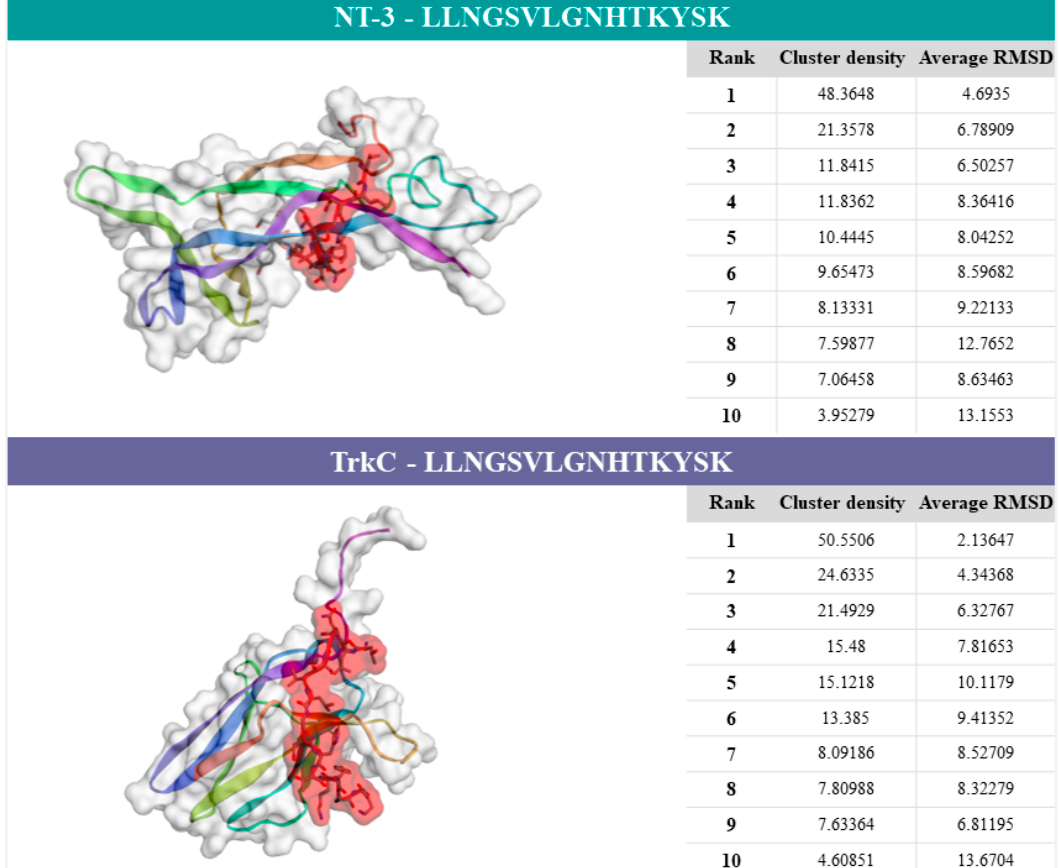
Figure 3. Fluorescence microscopy images of blood T lymphocytes. Legend: fluorescence micros- copy images of blood T lymphocytes. T cells were stained with anti-NEText + anti-Alexa Fluor 488 (green color) and anti-NT-3 + anti-Alexa Fluor 594 (red color) antibodies; or anti-NEText + anti- Alexa Fluor 488 (green color) and anti-TrkC + anti-Alexa Fluor 594 (red color) and expanded from peripheral blood mononuclear cells with an HCX PL APO CS 63.0 × 1.40 OIL UV objective. The white bar represents 10 µm. ( a ) NEText–NT-3 staining of T lymphocytes of patients with schizophrenia and controls. ( b – d ) Intensity profile graphs (distance in pixels vs. intensity in grey-scale values) of T cells of patients with schizophrenia (red) and controls (green): ( c ) distribution of NEText, ( d ) distribution of NT-3, and ( e ) distribution of merged results. NEText–TrkC staining of T lymphocytes of patients with schizophrenia and controls. ( f – h ) Intensity profile graphs (distance in pixels vs. intensity in grey-scale values) of T cells of patients with schizophrenia (red) and controls (green): ( f ) distribution of NEText, ( g ) distribution of TrkC, and ( h ) distribution of merged results.